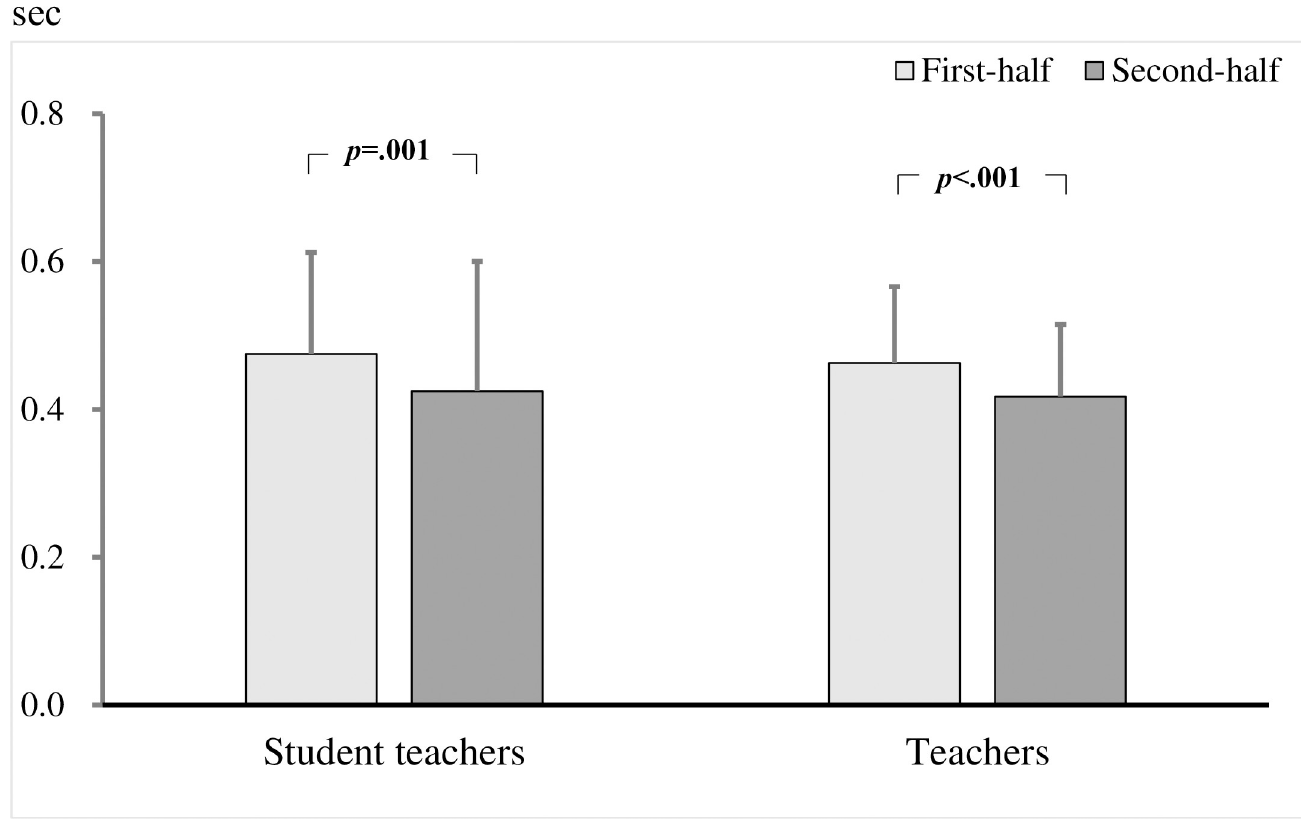
Fig 5. Fixation duration per fixation on non-target areas in student teachers and teachers. Bars show the mean across all comparisons (with standard deviation bars).